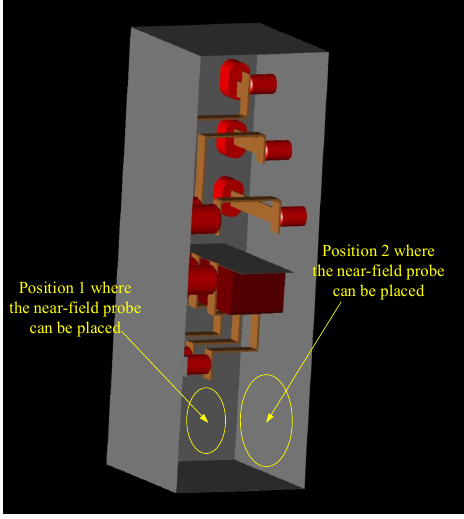
Figure 17. Position in which the near - field probe can be placed .